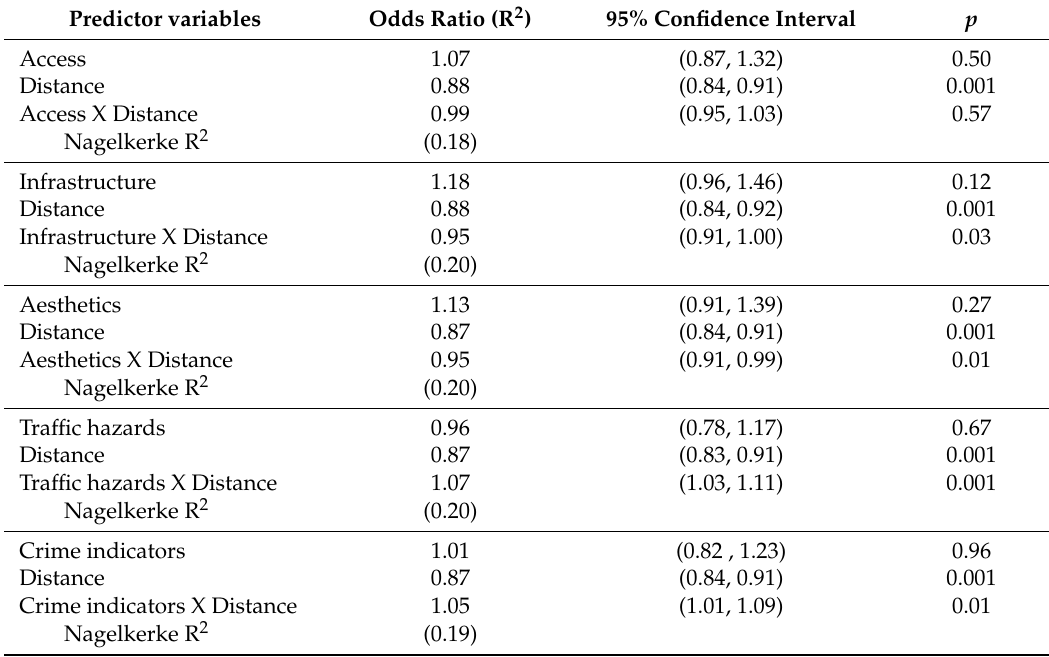
Table 2. Perceived walkability and distance associated with active transportation to the complete street in 2013: logistic regression